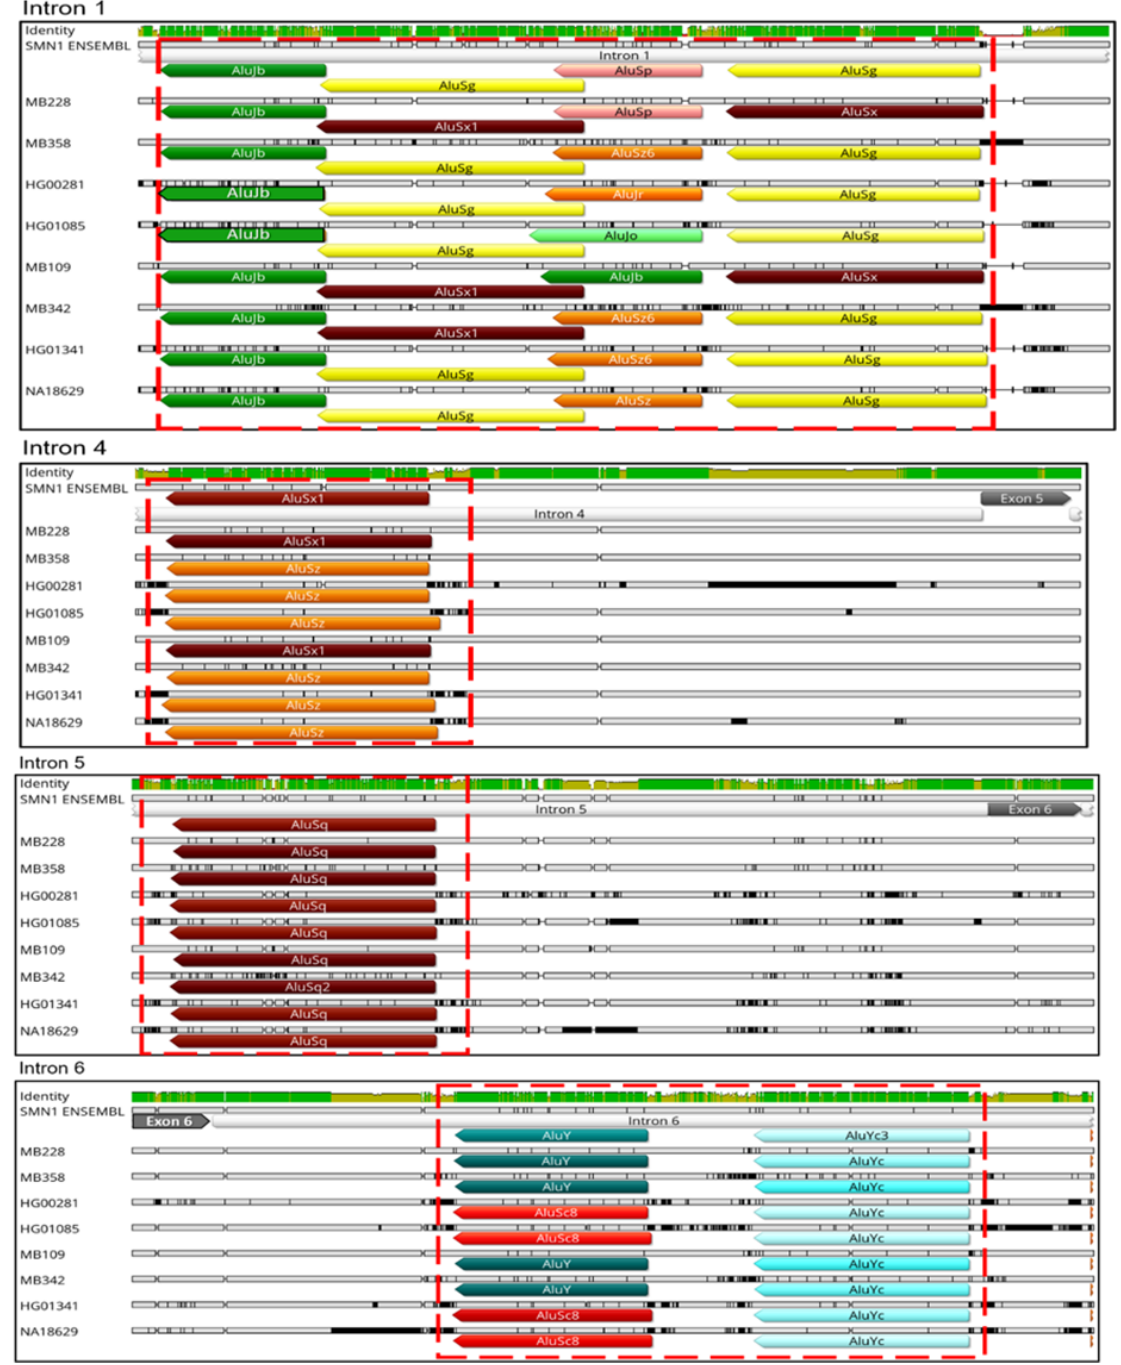
Figure 7. Identification of Key Alu repeats involved in RNA circularization events within SMN1/2 . Comparison between key Alu repeats involved in SMN1/2 circularization events (inside the red boxes) located in introns 1, 4, 5 and 6. Independently of disease status, a conservation of position and orientation of the Alu insertions is visible. SMA patient samples (MB228 and MB358); SMA carriers (HG00281 and HG01085); healthy samples (MB109 and MB342) and Non-carrier samples (HG01341 and NA18629). Color codes for the arrows: green, AluJb; pink, AluSp; yellow, AluSg; orange, AluSz6; light green, AluJo; dark red, AluSx1; teal, AluY; light blue, AluYc and red, AluSc8.